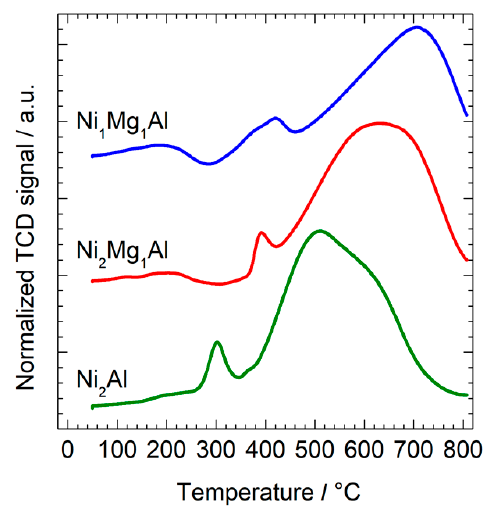
Table 4. Specific hydrogen consumption during the TPR of the LDH precursors calcined at 400 °C for 4 h.